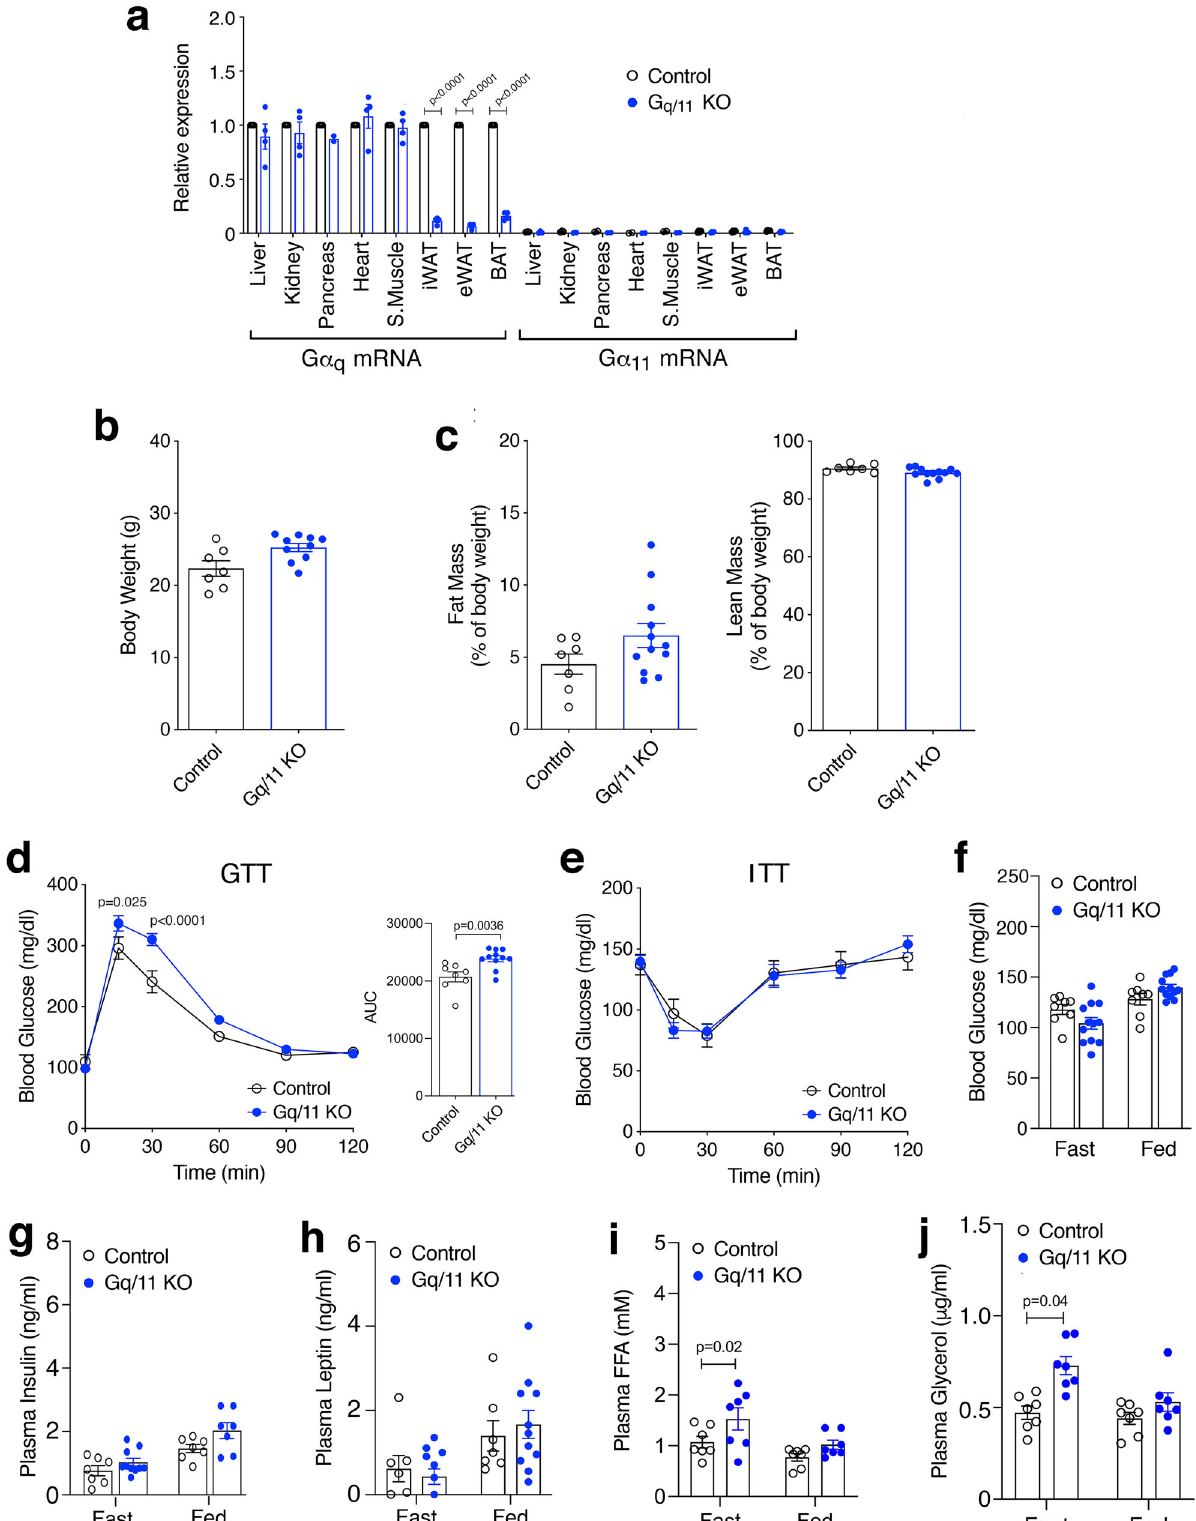
insulin treatment reduced blood glucose and plasma FFA levels to a similar degree in control and adipo-G q/11 KO mice (Supple- mentary Fig. 9a, b). Moreover, studies with 3T3F442A